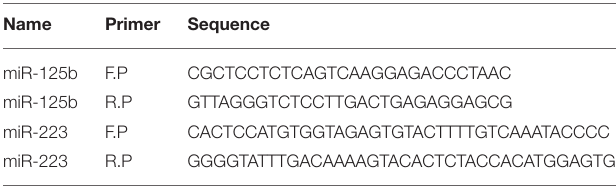
TABLE 4 | Primer sequences used for site-directed mutagenesis of miR-125b and